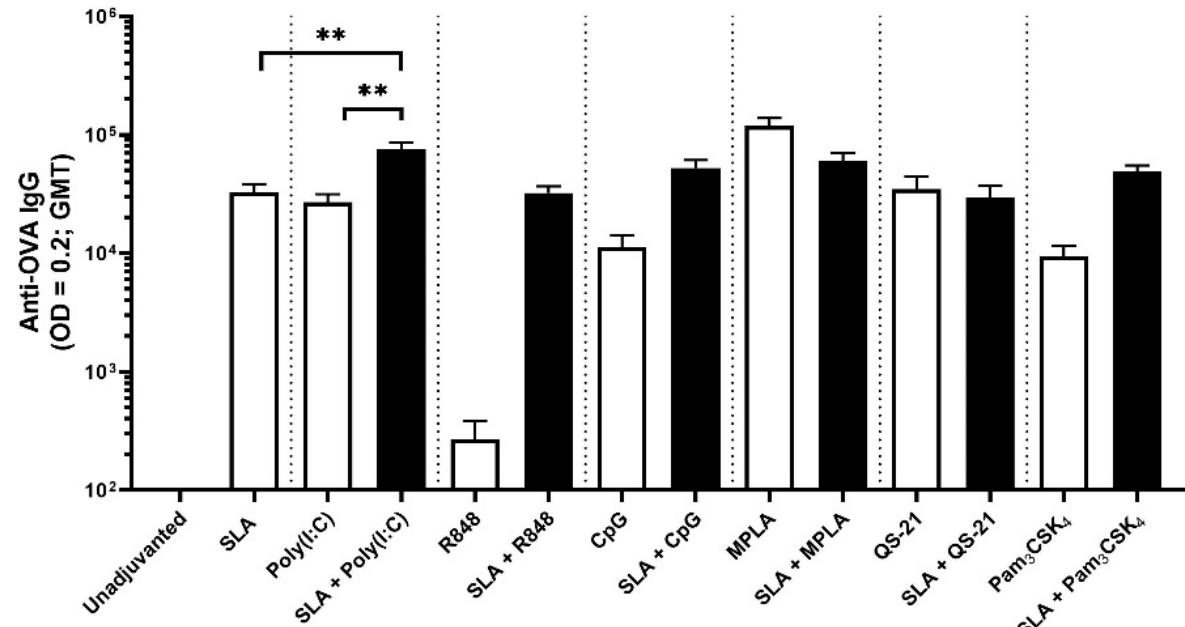
Figure 2. OVA-specific antibody titers in mice. Mice were immunized with OVA antigen alone or formulated with SLA archaeosomes, other adjuvants (Poly(I:C), R848, CpG, MPLA, QS-21 and Pam 3 CSK 4 ) or SLA in combination with other adjuvants on days 0 and 21. On day 28 (7 days post-2nd immunization), serum was collected and levels of antigen-specific IgG antibodies measured by ELISA. Grouped data are presented as geometric mean titer + 95% confidence interval ( n = 10/group). ** represents p <